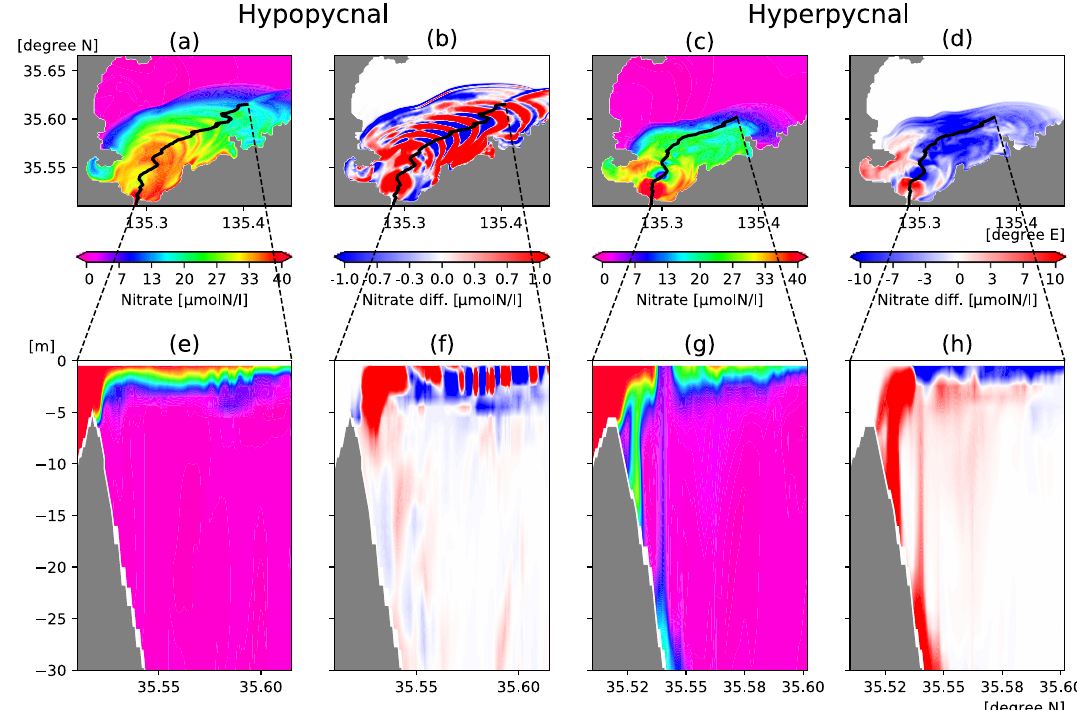
Figure 7. As Fig. 6, but for nutrients (nitrate). Blue–red color contrasts are opposite to those of salinity differences in Fig. 6. This figure was prepared with matplotlib ver. 3.3.1 in Python ver. the sub-surface concentration, and below which the riverine nutrient concentration is lower. The further to the right on the horizontal axis, the larger are the absolute values of the differences resulting from the SSM–physical interaction. The interactive processes produce consistent results for the hypopycnal and hyperpycnal cases. In the hypopycnal case (Fig. 8a), the surface water tends to become more isolated, so the surface layer becomes more nutrient-rich (poor) when the riverine nutrient concentration is higher (lower) than the sub-surface layer. In the hyperpycnal case (Fig. 8b), the opposite tendency is observed because the surface water and sub-surface water tend to mix. Thus, the SSM–physical interaction can have opposite effects on river-originated tracers, such as nutrients, depending on the surrounding situation. The larger (smaller) the difference in concentration between river water and the sea sub-surface, the larger (smaller) is the quantitative impact. The effect of consumption by PHY is not yet apparent in the nutrient concentration differences, because the phytoplankton are still consuming the nutrients. In the hypopycnal case (Fig. 8c), the trend is similar to that of nutrient concentration difference, but the trends differ in the hyperpycnal case (Fig. 8d). This result reflects the mixing effect with water in the lower layer, which contains a relatively higher PHY concentration due to the sub-surface maxima, rather than the effect of increasing or decreasing surface nutrients.